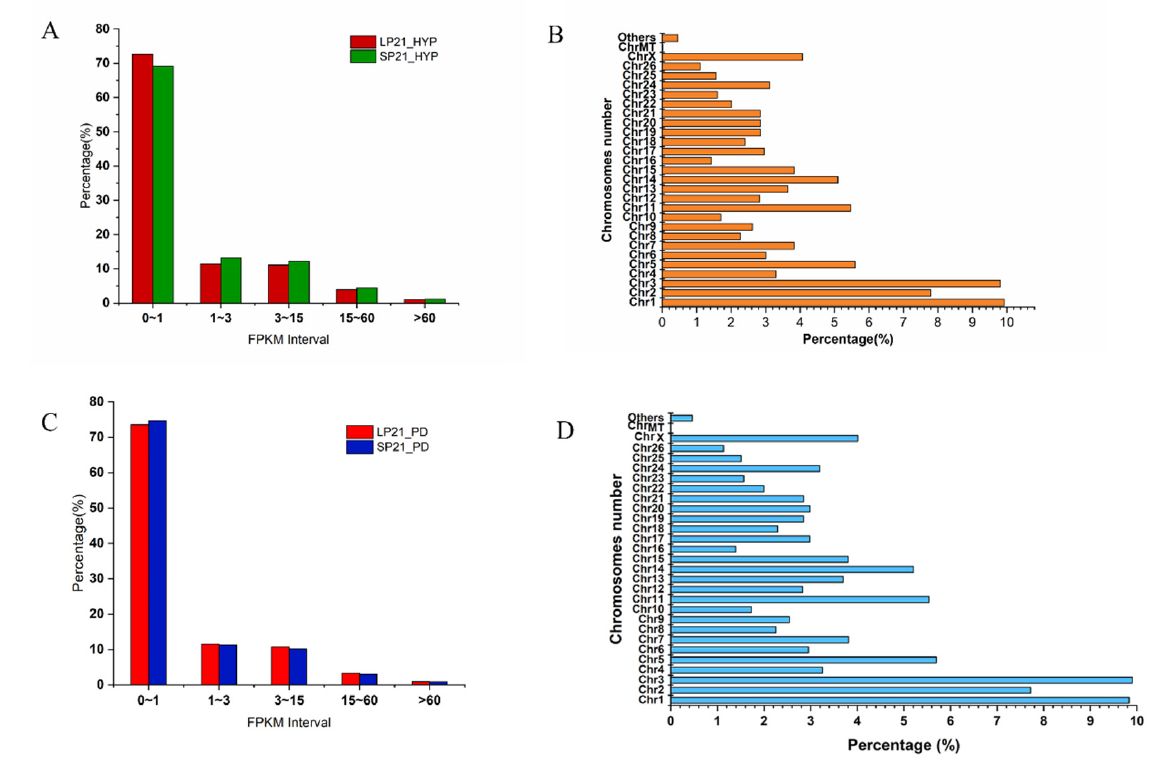
Figure 1. FPKM ( A ) and Chromosome ( B ) distribution of identified g expressed genes in SP21 − HYP vs. LP21 − HYP; FPKM ( C ) and Chromosome ( D ) distribution of identified expressed genes in SP21 − PD vs. LP21 − PD.